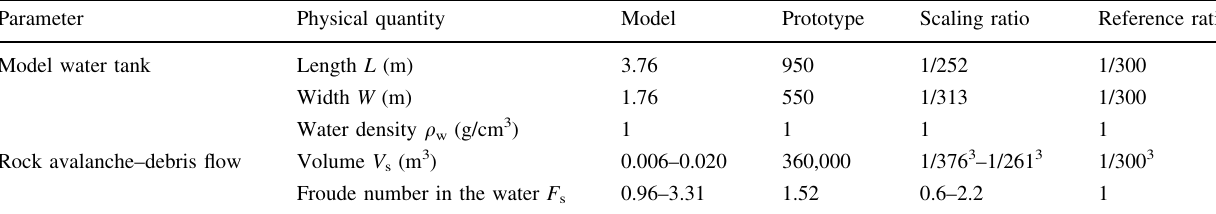
Table 1 Parameter comparison between prototype lake and model Parameter